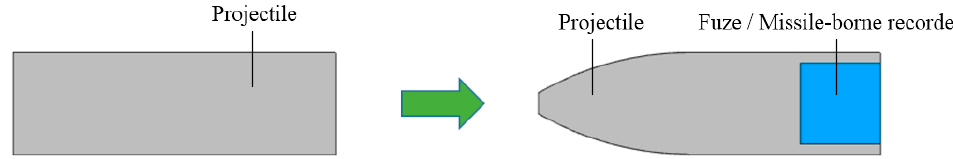
Figure 25. Sample structural design for a high g loading test.